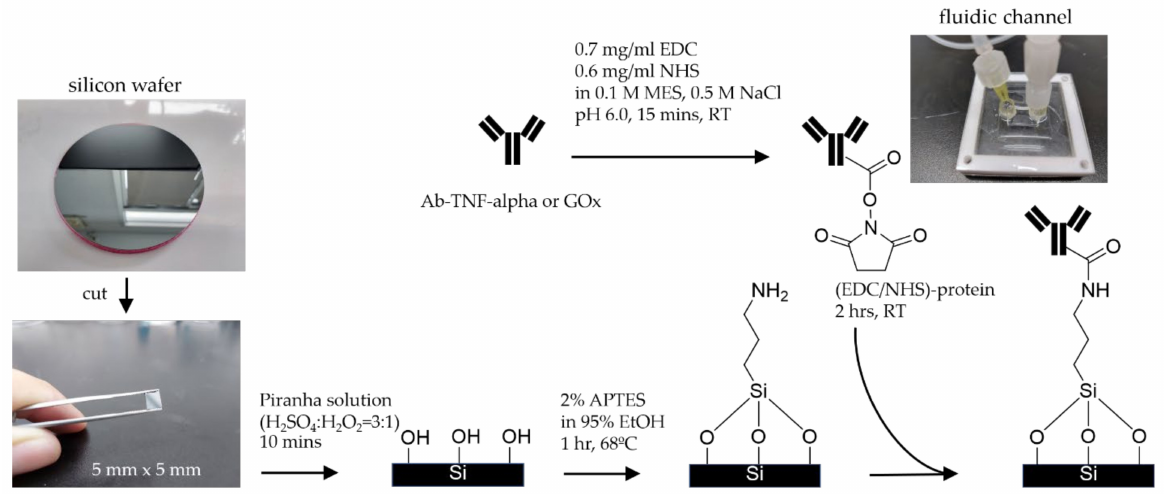
Figure 4. APTES-(EDC/NHS) coating